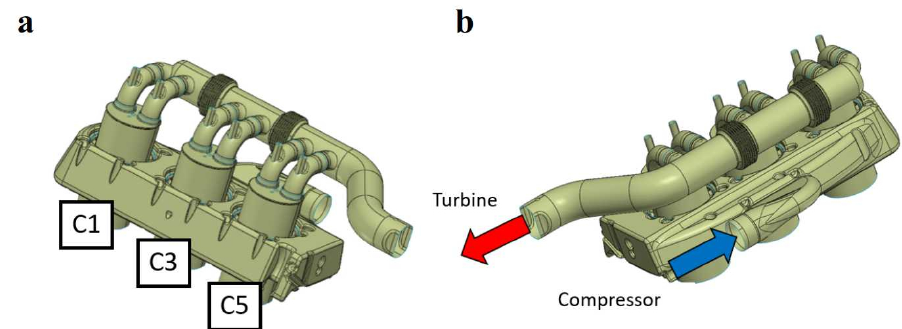
Figure 1. Internal ( a ) and external ( b ) views of the engine right bank. C1, C3 and C5 stand for Cylinder 1, Cylinder 3 and Cylinder 5.